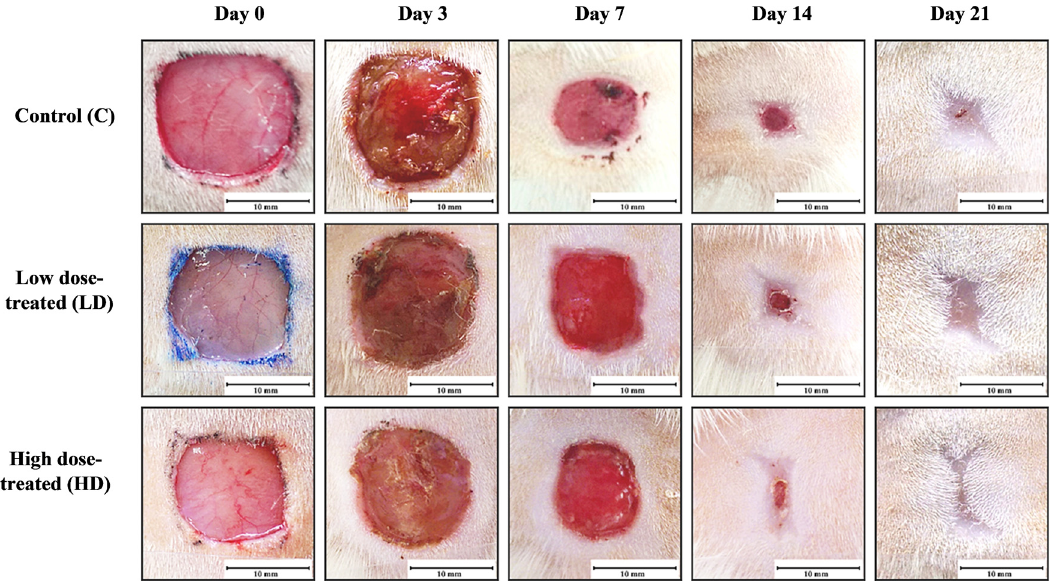
Figure 2. Macroscopic observation of wound healing progress in control and extract-treated groups at given post-wounding time points.